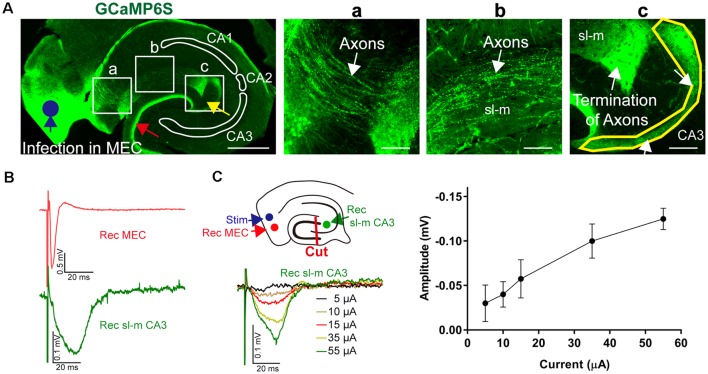
Anatomical and functional evidence of MEC to CA3 connectivity through stratum lacunosum moleculare (sl-m). (A) A fluorescence image of a 30-μm section of a representative acute-hippocampal slice depicts the MEC and the hippocampal formation. The MEC was infected with AAV9-hSyn-GCaMP6s (blue circle). MEC axons terminated in the medial pathway of the DG (red arrow) and within the sl-m CA3 region (yellow arrow). Horizontal scale bar: 500 μm. (a) Axons (white arrow) are depicted innervating the hippocampus and reaching the sl-m layer. (b) The enhanced fluorescence images indicate MEC axons in sl-m (white arrow). (c) The termination of MEC axons in the CA3 region (white arrow and yellow outline) is shown. Horizontal scale bar = 100 μm. (B) Functional analysis of connectivity was utilized by stimulation at the MEC (layer II/III, blue circle) using a metal electrode and recording in MEC and sl-m of CA3 (green circle) in slices with dissected DG (red line, cut), as shown in the schemata. Representative LFPs are depicted for MEC (red) and sl-m CA3 (green). (C) Increase of the stimulation strength resulted in a gradual increase of sl-m CA3 LFPs. The line graph summarizes the stimulation intensity–dependent increase of LFP amplitude (n = 4).